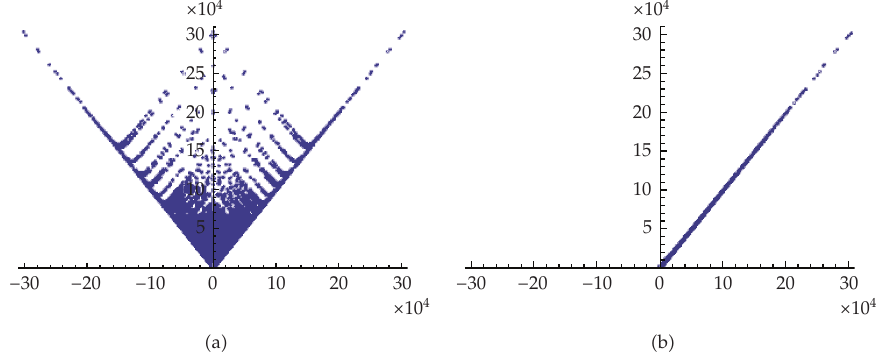
Figure 6: (cid:5) a (cid:6) The Hodge numbers, with h 1 , 1 − h 3 , 1 as the abscissa and h 1 , 1 (cid:8) h 3 , 1 , the ordinate, of the fourfolds from Kreuzer-Skarke’s database. (cid:5) b (cid:6) The same, but with h 1 , 1 − h 2 , 1 , as the abscissa and h 1 , 1 (cid:8) h 2 , 1 as the